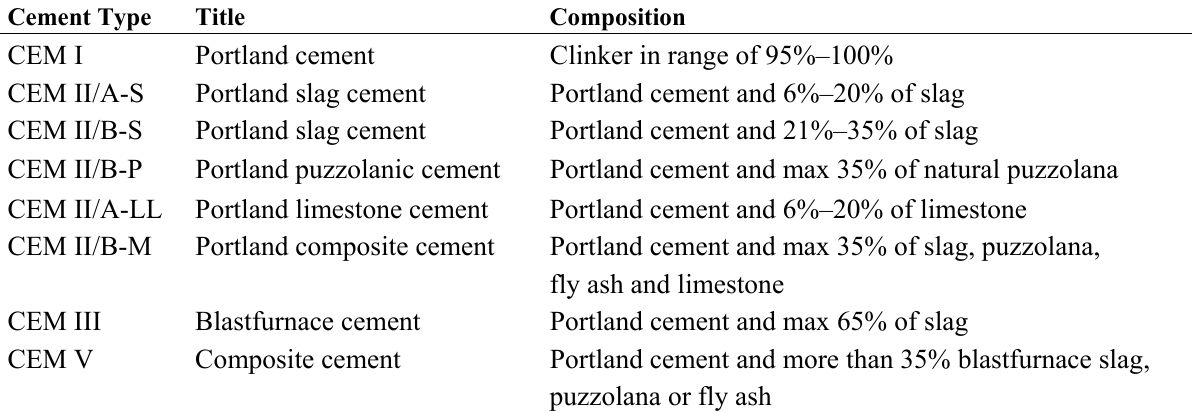
Table 1. The characteristics of assessed cement types.